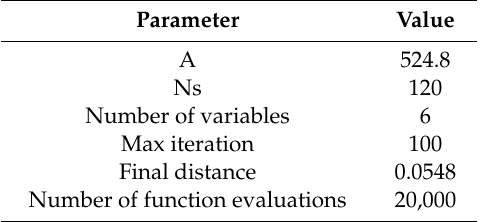
Table 1. Optimal mine blast algorithm controlling parameters.